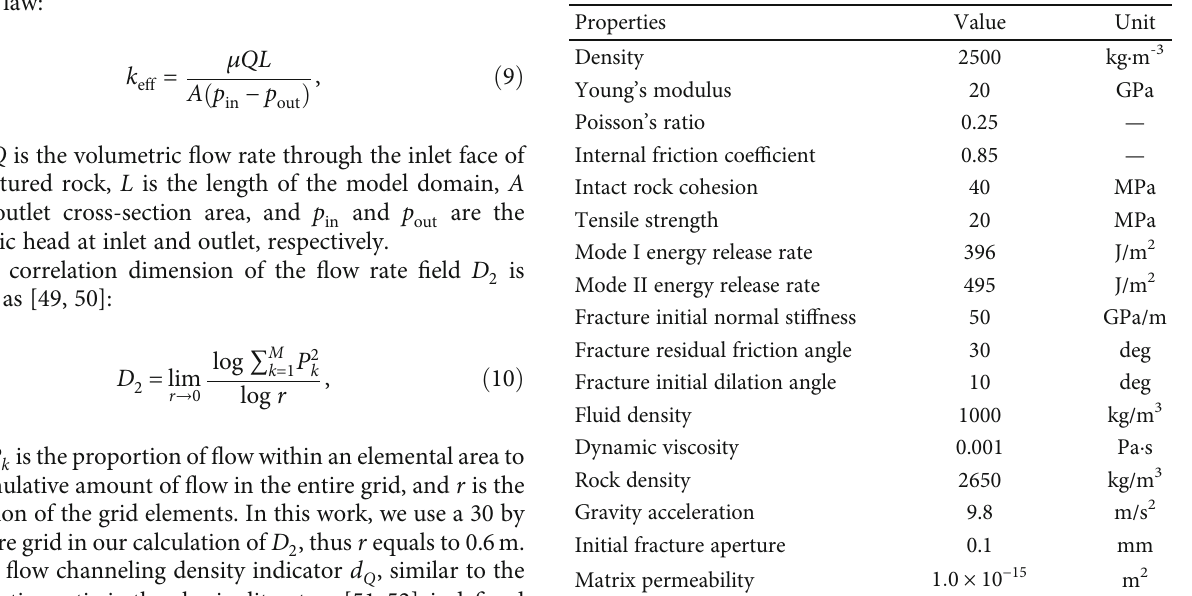
Table 1: Material properties for geomechanical